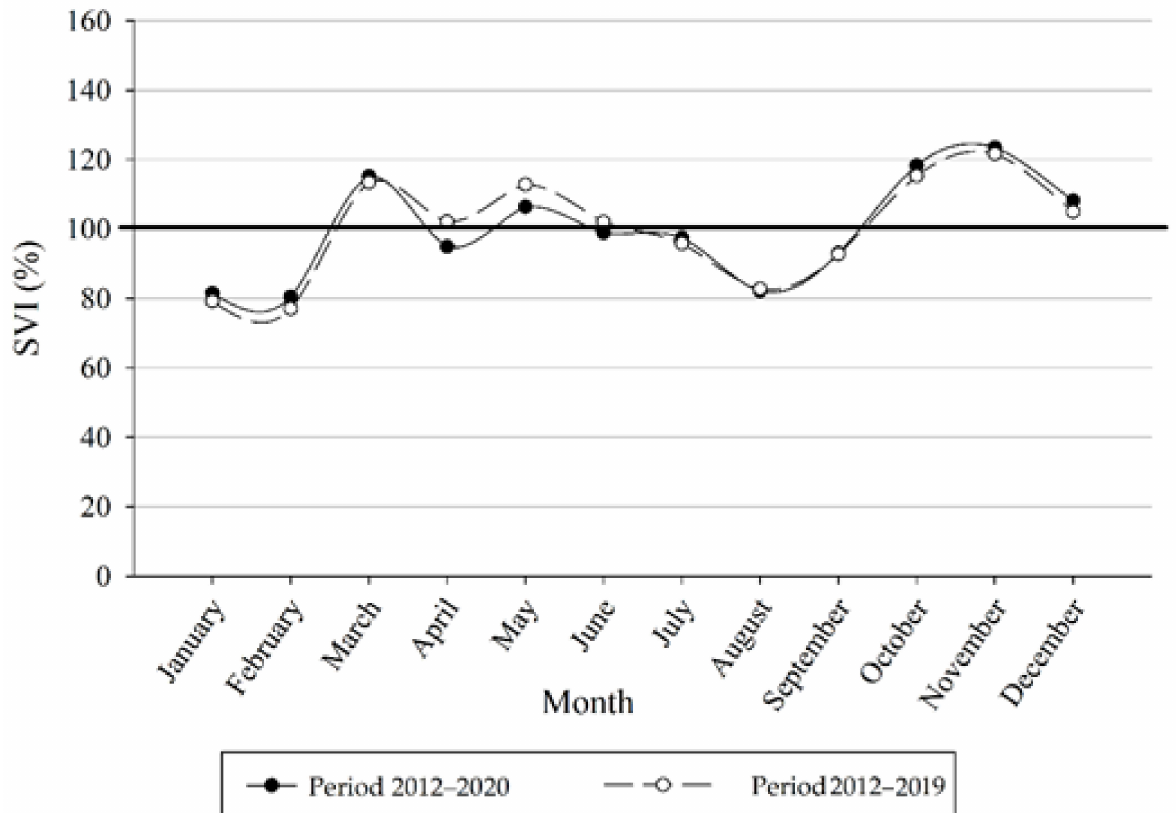
Figure 9. Seasonality pattern of vehicle disembarking traffic of the port of Barcelona during the periods 2012–2019 and